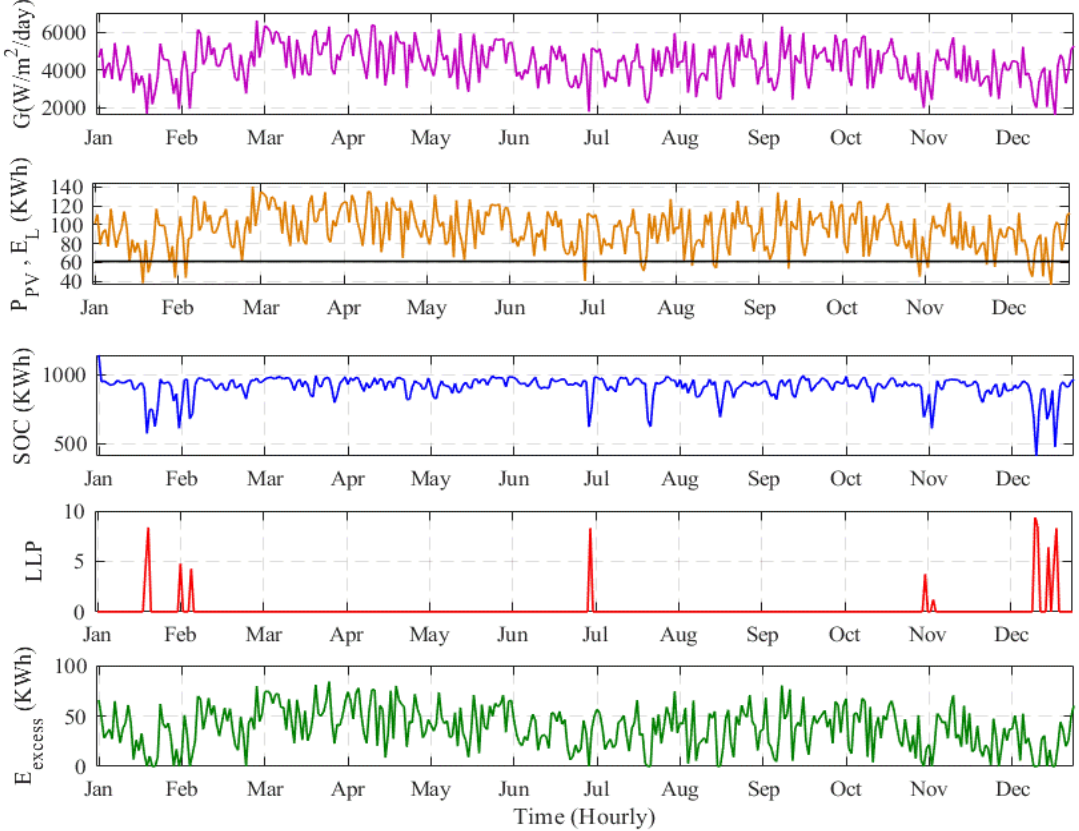
Figure 12. Daily performance of the SAPV system under optimal configuration for one year. Table 11. Performance data of SAPV system during shortage of days.